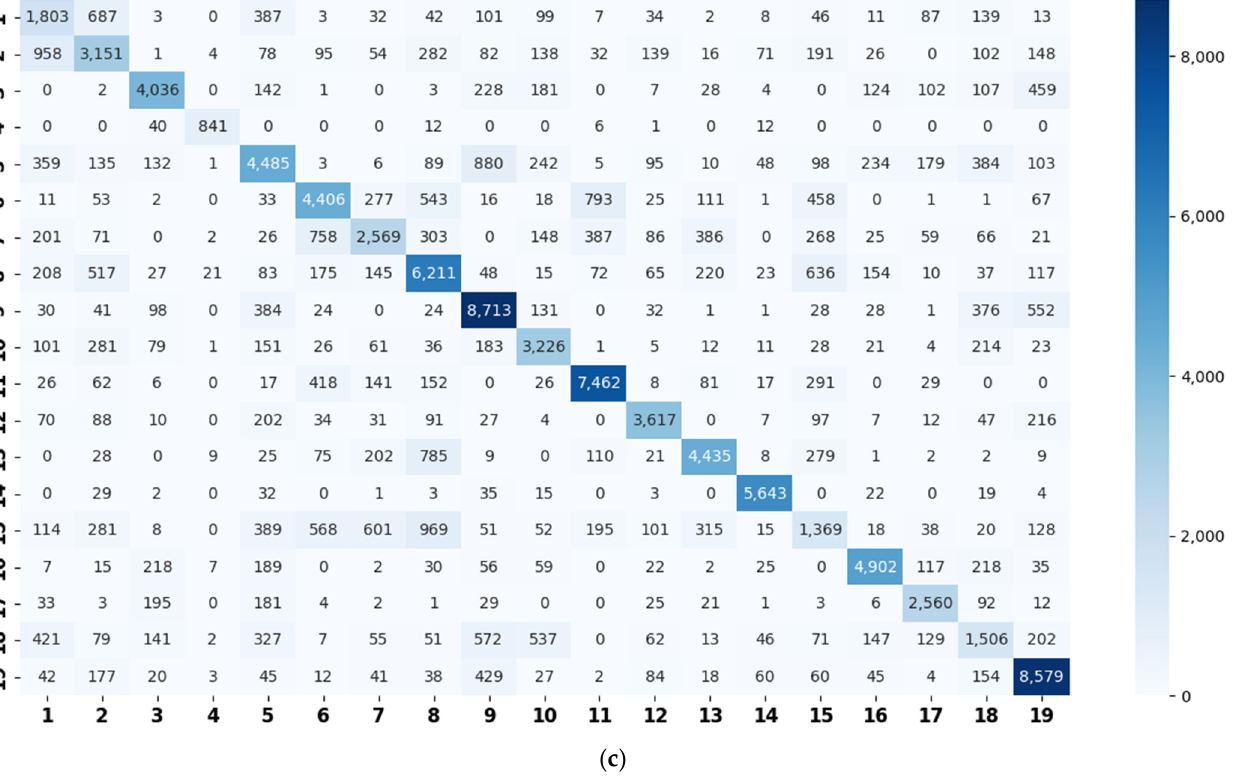
Figure 8. Confusion matrices on the LITIS Rouen dataset generated by the basic models ( a ) using STFT spectrograms; ( b ) using CQT spectrograms; and ( c ) using log-Mel spectrograms. The abscissa represents the predicted label, and the ordinate indicates the true label. Note: Quiet street (1), busy street (2), restaurant (3), plane (4), shop (5), bus (6), train (7), metro Rouen (8), market (9), café (10), car (11), tubestation (12), high speed train (13), kid game hall (14), metro Paris (15), billiard pool hall (16), student hall (17), pedestrian street (18), and train station hall (19). Table 4. Clustering details of the constructed super-class for the LITIS Rouen dataset. The classes marked by the same shape with the same color are grouped into the same super-class. Generated by Generated by CQT Generated by Clustering Scheme STFT Model Model Log-Mel Model